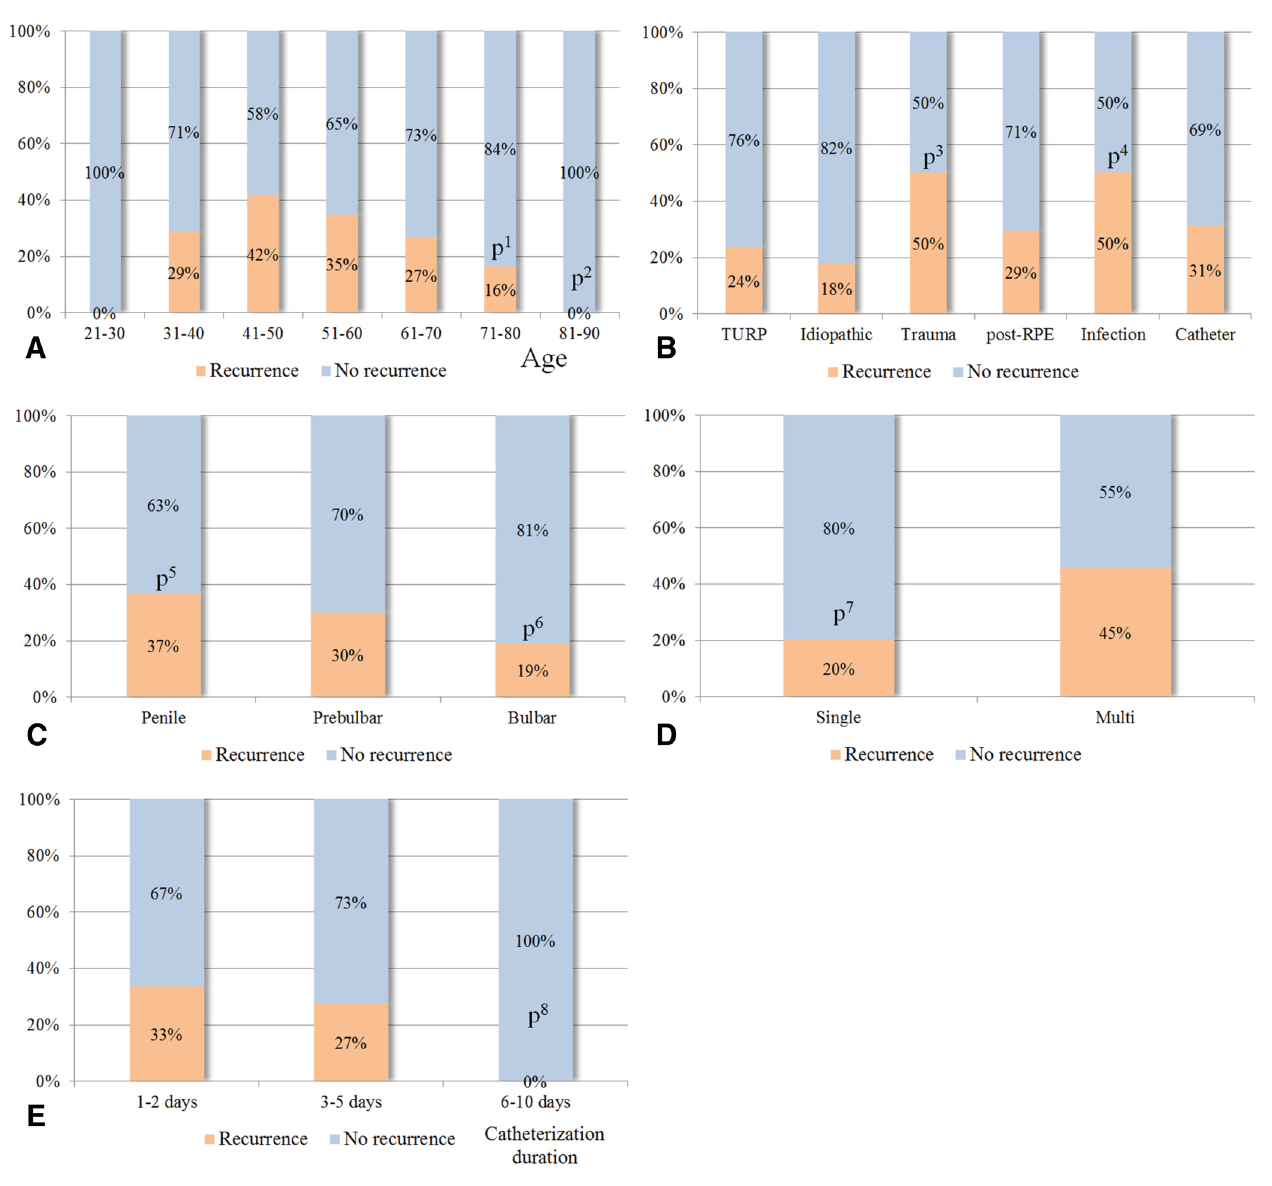
Figure 5. Recurrence rate after the 1 st optical internal urethrotomy in patients with a urethral stricture with a length of 1–2 cm. A - Recurrence rate with respect to the patient age (p 1 , p 2 <0.05 compared to all other groups). B - Recurrence rate with respect to the stricture etiology (p 3 , p 4 < 0.01 in comparison to other groups). C - Recurrence rate with respect to the stricture localization (p 5 <0.01 to bulbar, p 6 < 0.05 to prebulbar). D - Recurrence rate with respect to the number of consecutive strictures in each of the patients (p 7 <0.001). E - Recurrence rate with respect to the catheterization duration (p 8 <0.01 compared to the other two